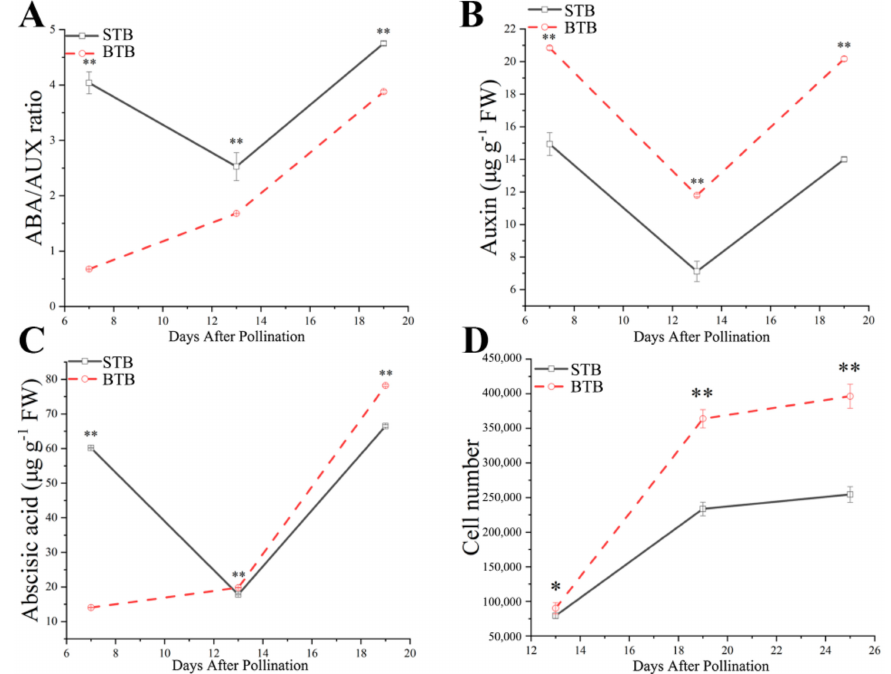
Figure 3. AUX and ABA profiles of the two accessions. ( A ) The corresponding ratios of ABA to AUX from the above figures are plotted against the developmental age of the fruits (DAP) of STB (black squares) and BTB (red circles). ( B ) AUX levels of the two Tartary buckwheat accessions (STB, black squares; BTB, red circles) is plotted against the developmental stages (days after pollination) ( n = 3); ( C ) ABA levels of the two Tartary buckwheat accessions (STB, black squares; BTB, red circles) is plotted against the developmental stages (days after pollination) ( n = 3). ( D ) Cell proliferation during 13–25 DAP of fruit development (STB, black squares; BTB, red circles) ( n = 5); standard deviations are indicated in the different panels; * and ** indicate significant differences ( α = 0.05; α = 0.01, LSD) among treatments,